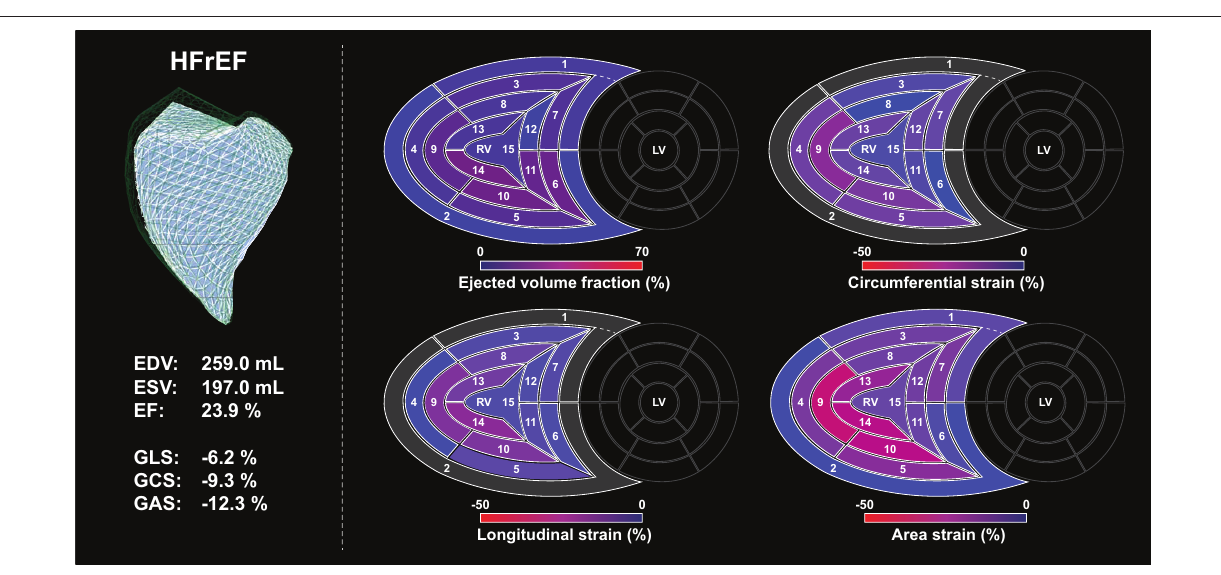
FIGURE 12 | Right ventricle of a patient (male, 29 years old) with end-stage heart failure with reduced left ventricular ejection fraction analyzed using the ReVISION method. Right ventricular end-diastolic and end-systolic volumes are increased, ejection fraction is severely reduced, along with global longitudinal, circumferential, and area strains. Segmental values of the aforementioned metrics at end-systole are depicted on bull’s eye heatmaps, the loss of function can be easily appreciated when compared to the maps of the healthy control ( Figure 11 ). Segment numbers as defined in Figure 3 . In the upper left corner, the green mesh represents the end-diastolic volume, and the blue surface corresponds to the end-systolic volume. EDV, end-diastolic volume; EF, ejection fraction; ESV, end-systolic volume; GAS, global area strain; GCS, global circumferential strain; GLS, global longitudinal strain; HFrEF, heart failure with reduced (left ventricular) ejection fraction; LV, left ventricle; RV, right